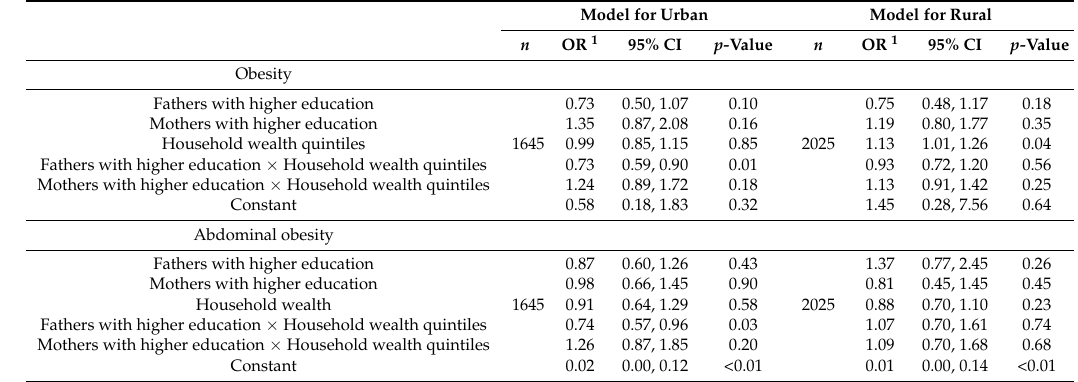
Table 7. Interaction between parent education and household wealth quintiles on obesity and abdominal obesity risk separated by residence area. Model for Urban Model for